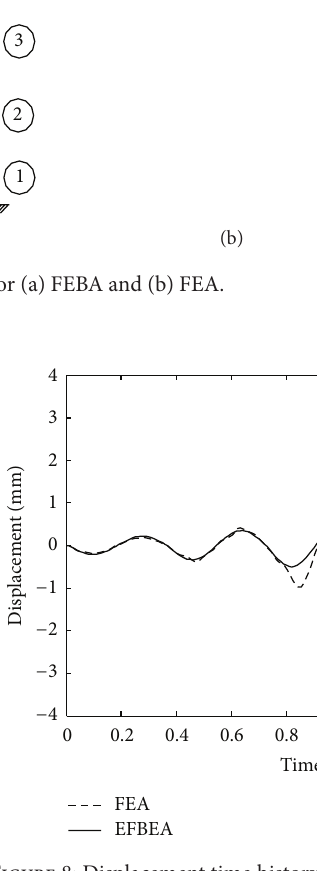
Figure 8: Displacement time history graphs of node 3 for FEA and